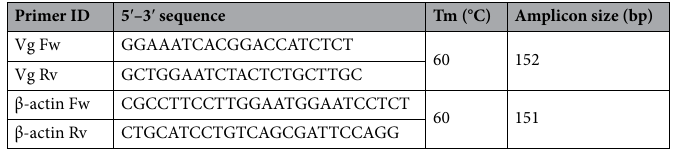
Table 2. List of the primers for quantitative PCR